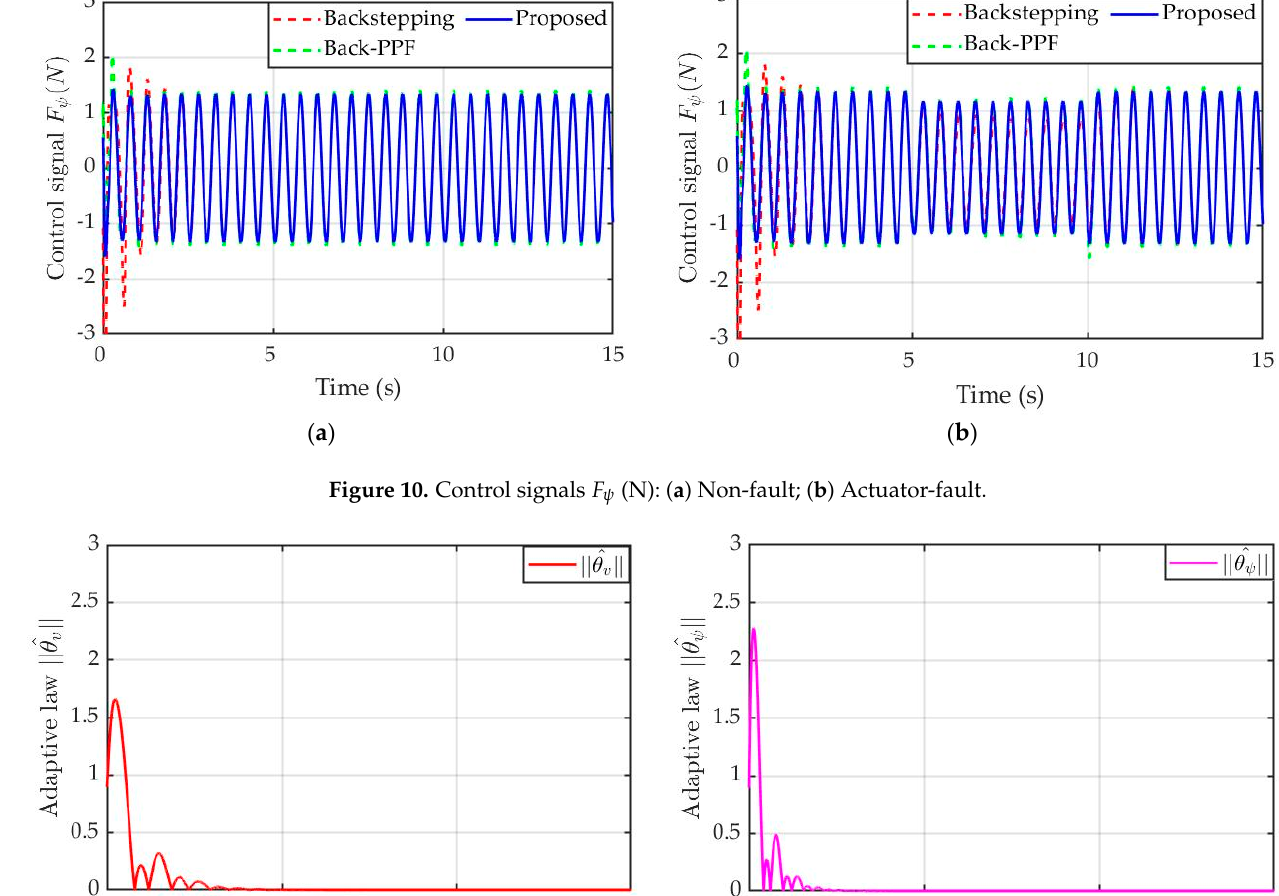
F (N): ( a ) Non-fault; ( b ) Actuator-fault. Figure 9. Control signals F v (N): ( a ) Non-fault; ( b ) Actuator-fault. v